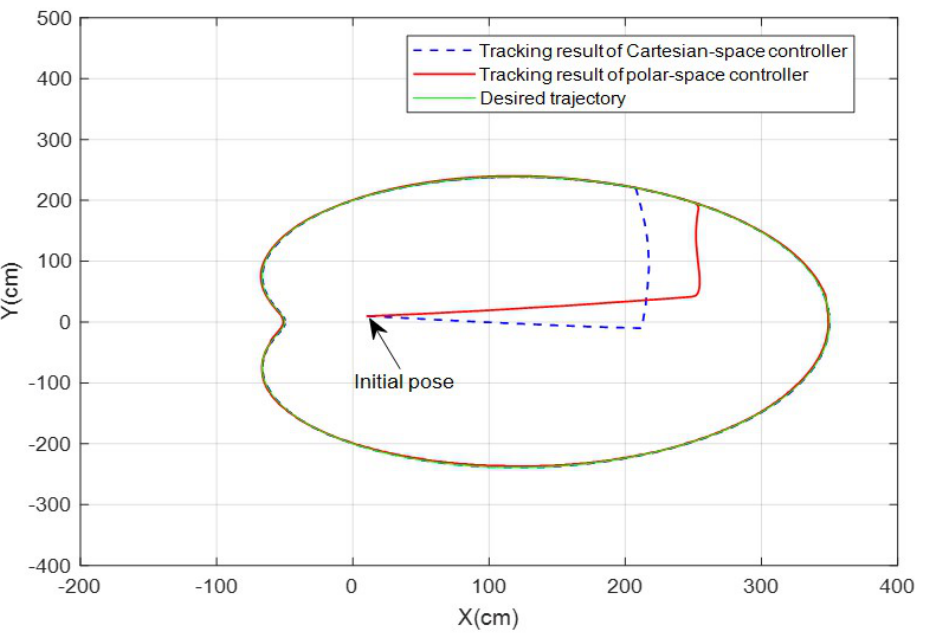
Figure 8. Cardioid trajectory tracking results in Cartesian and polar